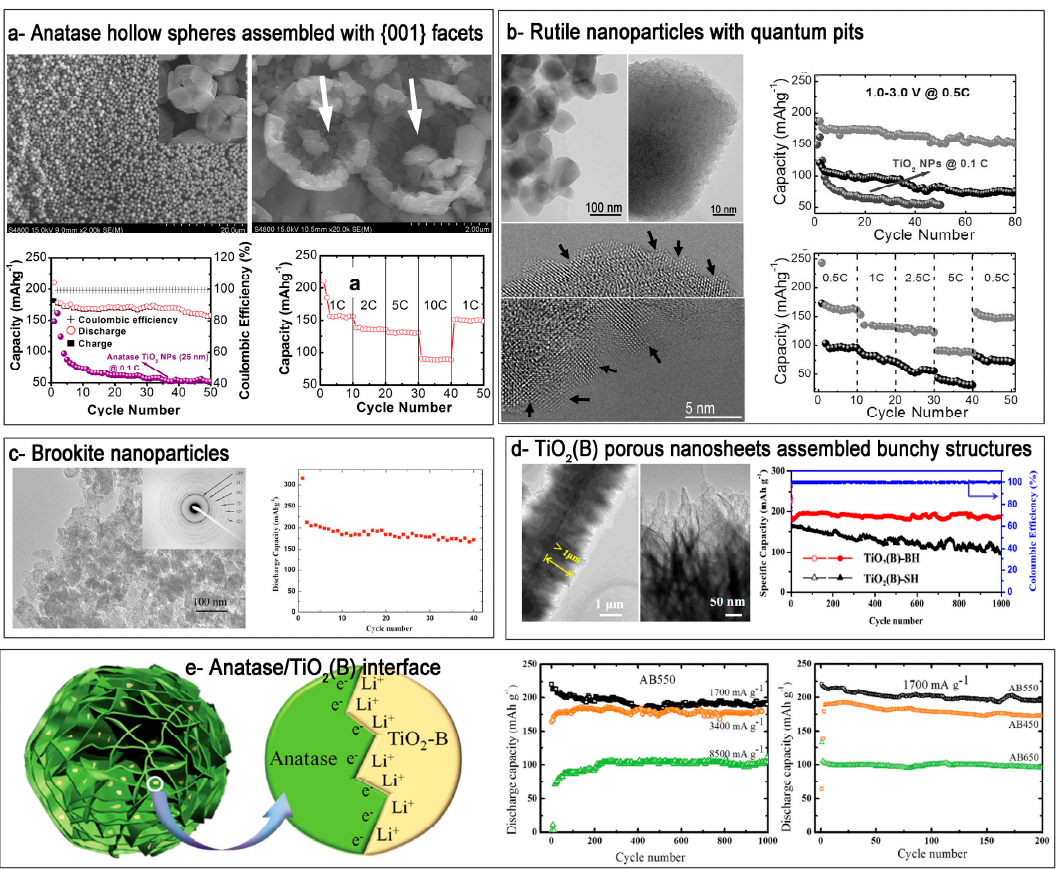
Figure 6. Typical TiO 2 anodes and their lithium storage properties: ( a ) three-dimensional (3D) anatase TiO 2 hollow microspheres assembled with high-energy {001} facets (reprinted from [105] with permission, Copyright The Royal Society of Chemistry, 2012); ( b ) Rutile TiO 2 nanoparticles with quantum pits (reprinted from [50] with permission, Copyright The Royal Society of Chemistry, 2016); ( c ) Brookite TiO 2 nanocrystalline (reprinted from [105] with permission, Copyright The Electrochemical Society, 2007); ( d ) bunchy hierarchical TiO 2 (B) structure assembled by porous nanosheets (reprinted from [119] with permission, Copyright Elsevier Ltd., 2017); and ( e ) Ultrathin anatase TiO 2 nanosheets embedded with TiO 2 (B) nanodomains (Reproduced with permission from [125], Copyright John Wiley & Sons,